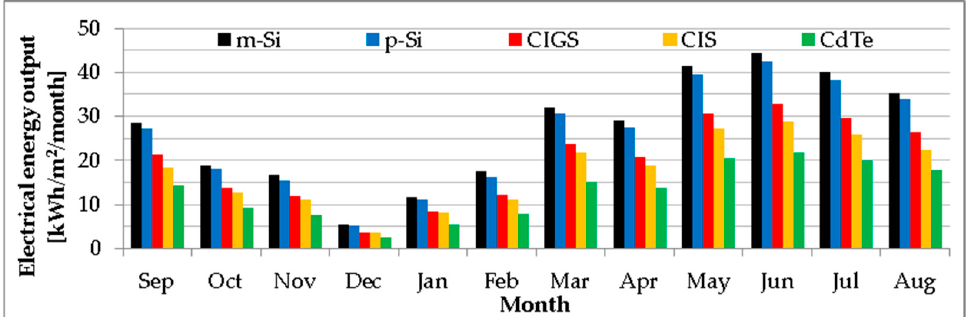
Figure 20. The monthly electrical energy output of the tracked photovoltaic modules.